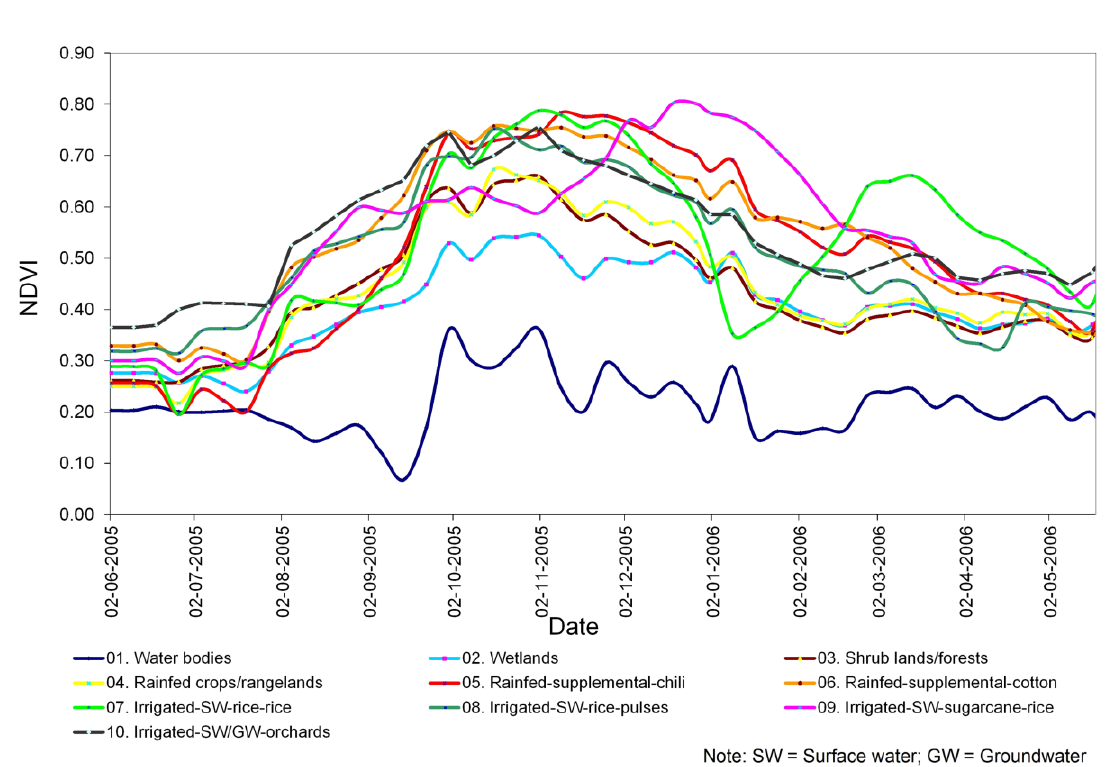
Figure 4. The temporal mean MODIS 250-m NDVI signatures (mean NDVI pattern) of